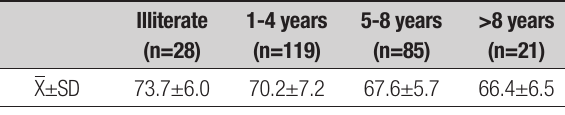
Table 1. Age comparisons by schooling level.